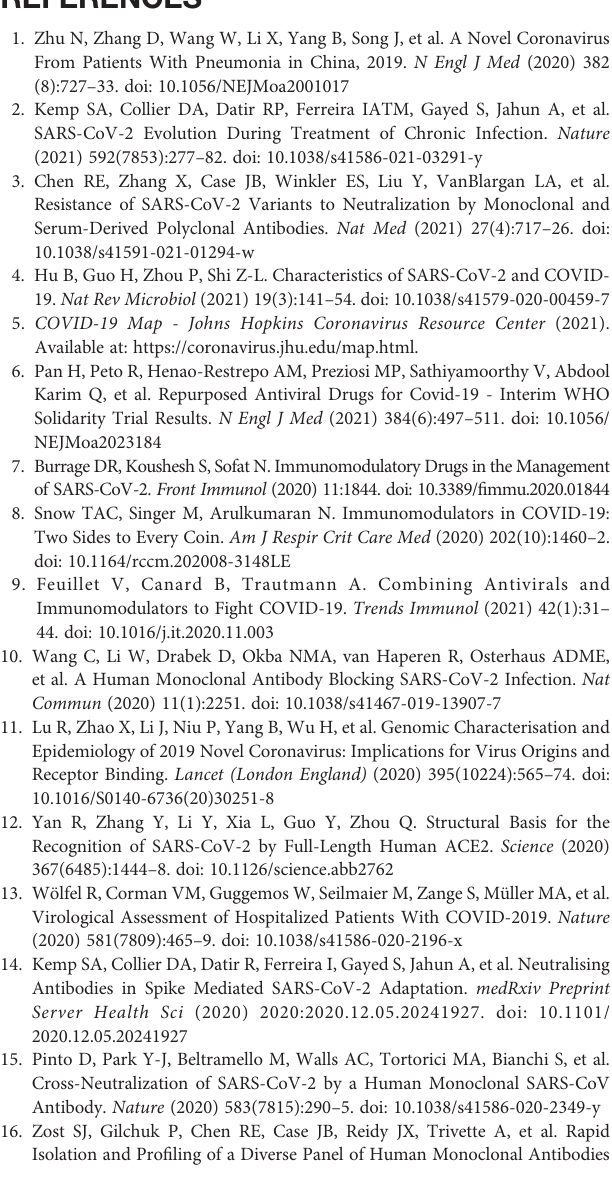
Supplementary Figure 2 | Neutralizing activity of anti-RBD pAbs against WT vs . E484K mutant SARS-CoV-2 strains using pseudovirus. Inhibition ratios of pAbs against WT and the E484K mutant SARS-CoV-2 pseudovirus were shown to be similar. Supplementary Figure 3 | Host responses in HBECs following SARS-CoV-2 infection, compared with the control. (A) Top 20 enriched relevant diseases and functions modulated in HBECs in response to SARS-CoV-2 infection ( p -value < 0.05). (B) Summary of enriched signaling pathways following SARS-CoV-2 infection. Supplementary Figure 4 | Gene ontology and pathway patterns for host responses in HBECs following SARS-CoV-2 infection, compared with the control. (A) Top enriched ontology clusters following viral infection. (B) Viral entry related